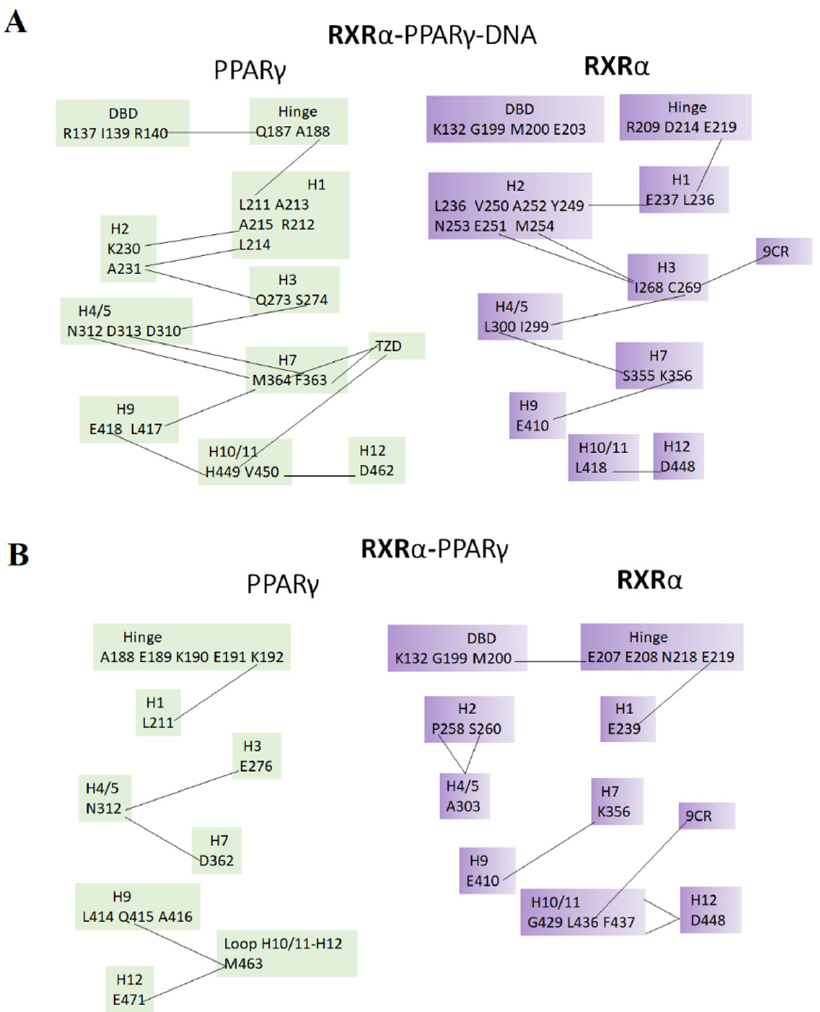
Figure 8. Intradomain correlated motions of RXR α -PPAR γ -DNA ( A ), and RXR α -PPAR γ ( B ) systems. Black lines denote correlated motions between domains.